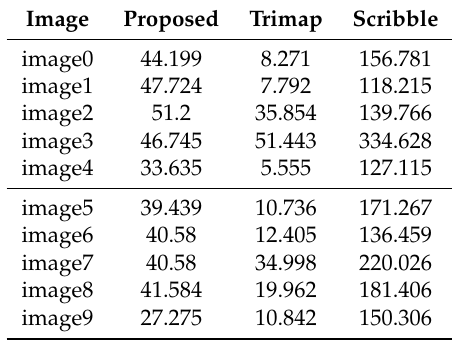
Figure 9. Partial trimap comparison results of experiment 2. Although the test class does not appear in the training class, the generated trimaps are still accurate enough (see column 3), the experimental results showed that our model has strong guidance ability. Table 4. Experiment 2: MAE statistics of the 20 test images; the matte obtained by